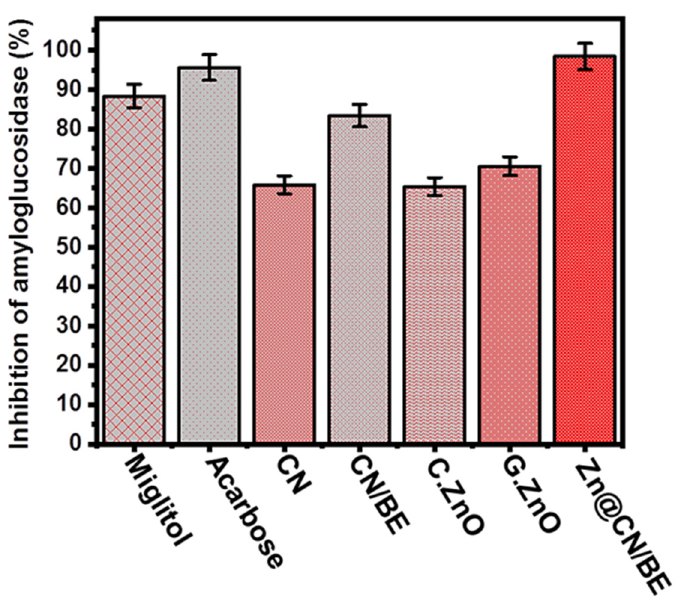
Figure 7. The amyloglucosidase (100 μ L; 0.1 unit/mL) inhibition activities of CN, CN/BE, commercial ZnO, green ZnO, and Zn@CN/BE structures (100 μ L; 100 μ g/mL) (the tests were replicated 5 times).